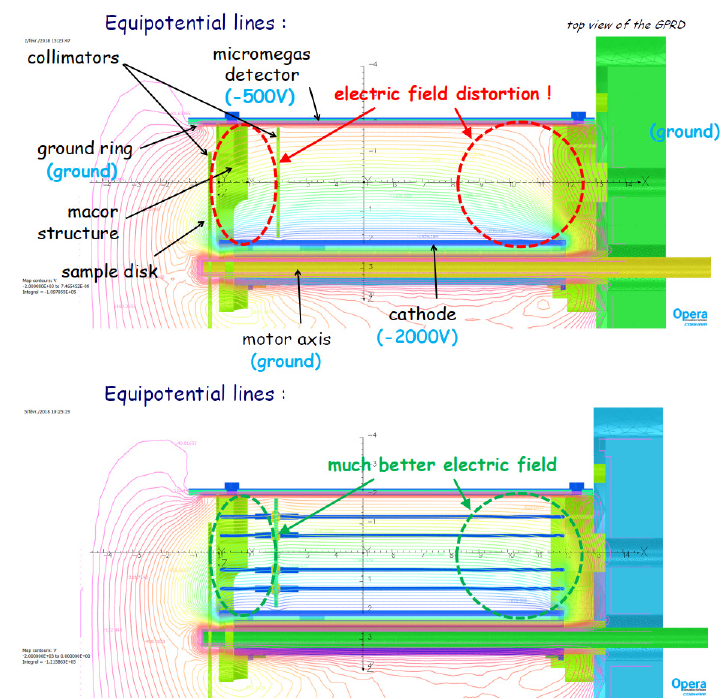
Figure 5. Equipotential lines simulated with the OPERA code. The setup accounts for the two colli- mators and the field cage (bottom) and no field cage